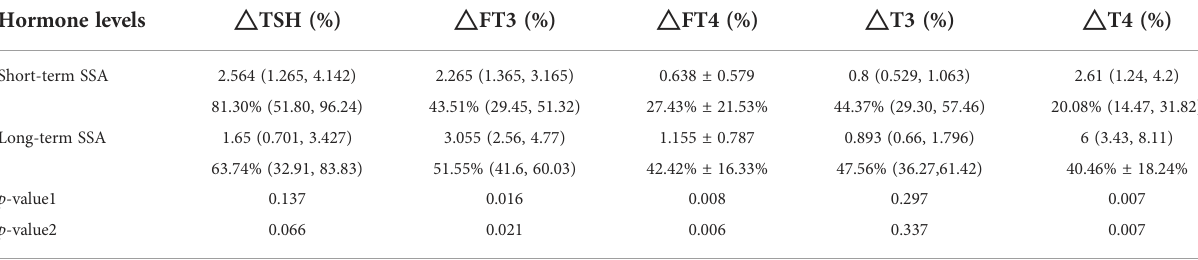
TABLE 3 Comparison of thyroid hormones that fall between presurgical long-term and short-term SSAs. Hormone levels